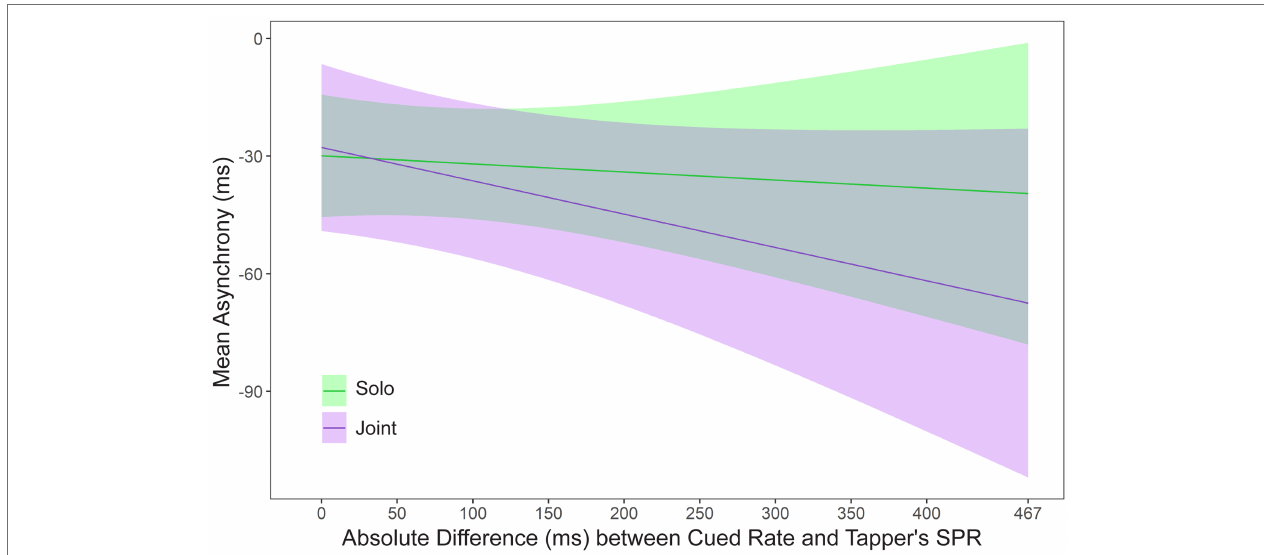
FIGURE 4 | Asynchronies predicted by the mixed model: Interaction between SPR Difference and Task. Zero on the x-axis represents the condition in which the metronome is cued at the tapper’s own